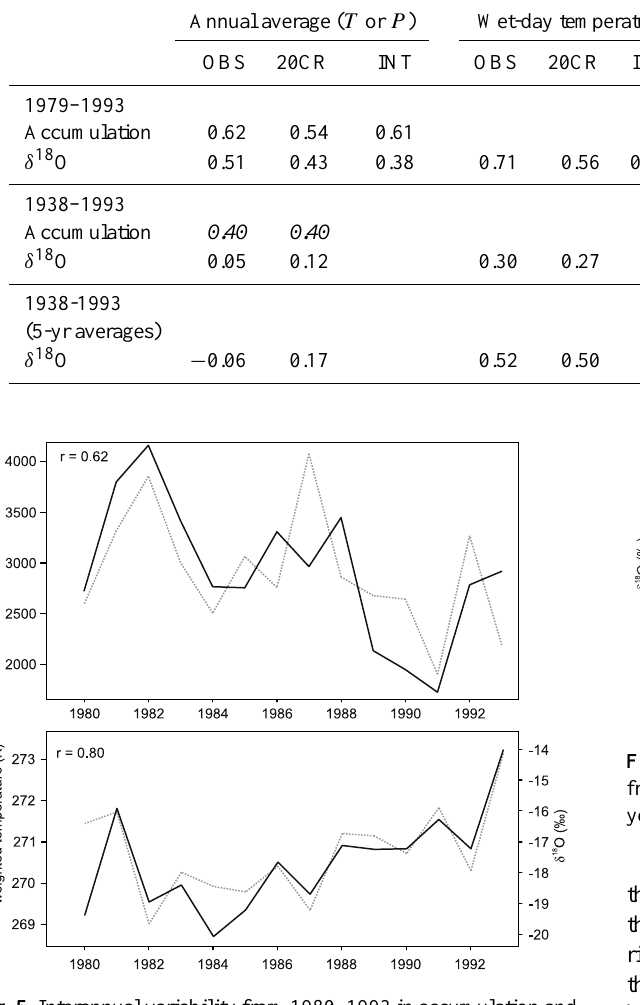
Fig. 5. Interannual variability from 1980–1993 in accumulation and δ 18 O from the ice core (black solid) and from the forward model (dashed grey line, PWT). The aggregation of samples into annual mean values was done according to the wiggles indicated in Fig. 3.